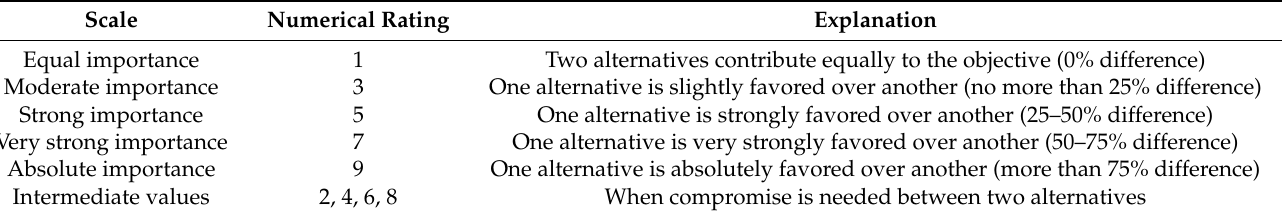
Table 3. Scale of relative importance.